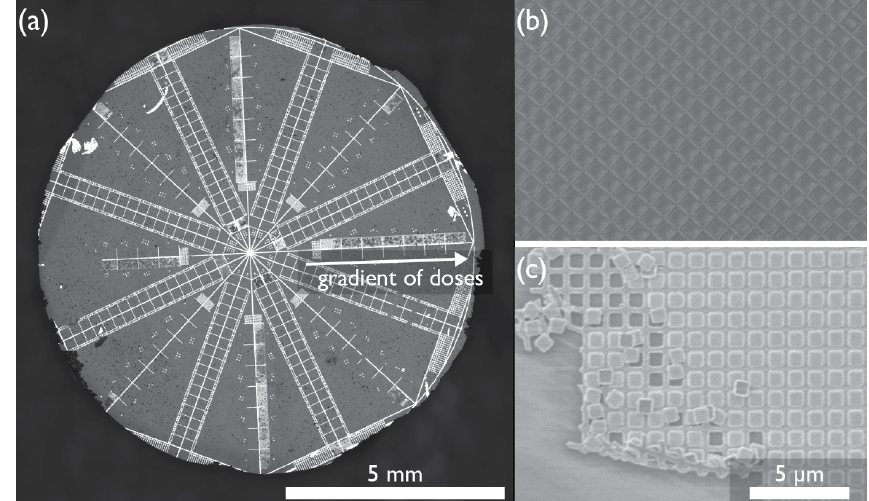
Figure 3. (a) Light micrograph of a patterned San Carlos olivine crystal. Electron-beam lithography was used with varying doses along the radial lines. All radial lines 10µm thick and exposed to a 900µCcm − 2 dose are visible; inside each rectangle different doses were tested: examples of a well-exposed and an overexposed area are seen in panel (b) and (c) , respectively. In the overexposed area, the pattern appears blurred, and causes the rounding of the corners in the grid. An underexposed area will typically show no signs of the pattern. The dose test allowed for the identification of the optimum dose to achieve the desired resolution: 700µCcm − 2 for 200nm wide lines.